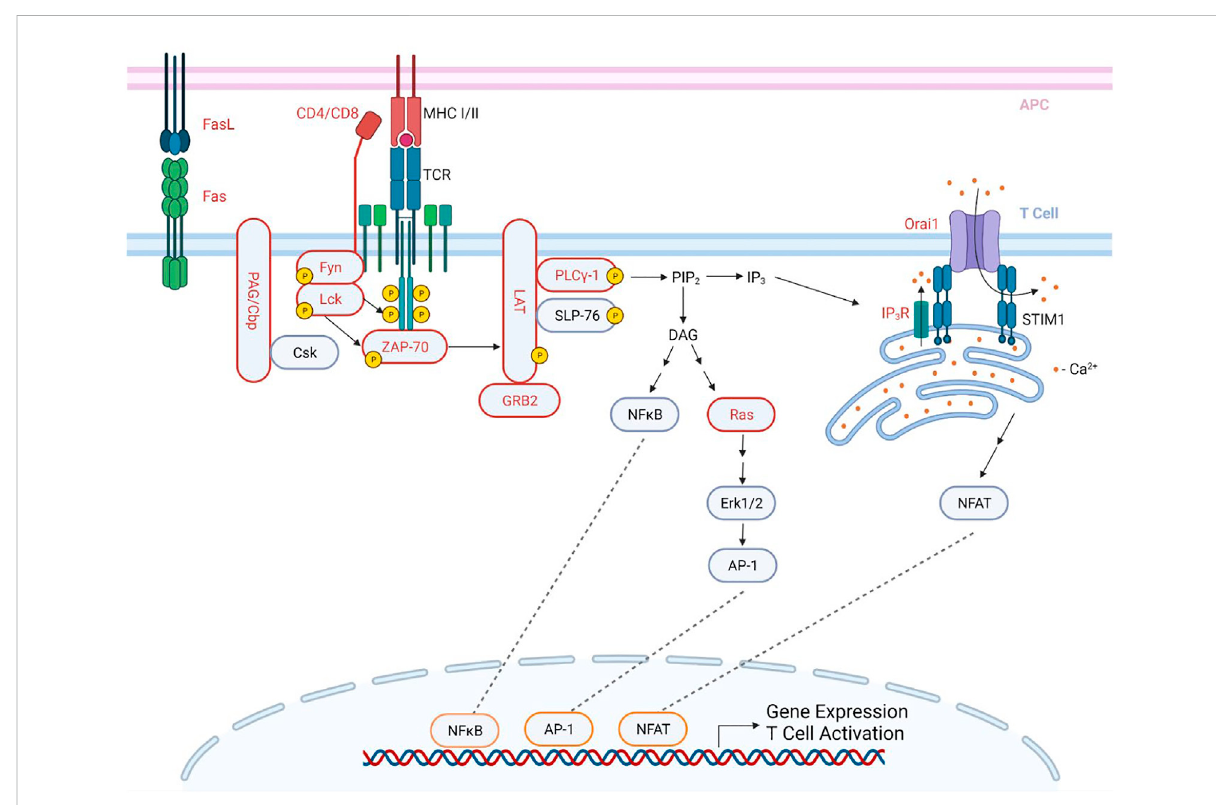
FIGURE 1 S-acylation in the proximal TCR signaling pathway. An antigen peptide, bound to an MHC of an antigen presenting cell (APC), engages and stimulatestheTCRwhileitsco-receptor(CD4/CD8)bindsto theMHC,resultingintheactivation ofseveralsignaling cascades, subsequentlyleading to T cell activation. Upon TCR stimulation, PAG/Cbp is de-phosphorylated, and disassociates from Csk, allowing for the recruitment of Lck to the TCR. Lck is then activated, and phosphorylates the ITAMs of the TCR-associated CD3 and ζ -chains. These phosphorylated ITAMs then act as a docking site for ZAP-70, which is then phosphorylated by Lck. ZAP-70 then phosphorylates and activates the scaffolding protein LAT, which is a dockingsiteforseveralproteins,includingSLP-76,PLC- γ 1,andGRB2.Thesearethenabletobephosphorylatedandactivated,manybyZAP-70.The activation of PLC- γ 1 leads to the formation ofIP 3 and DAG from PIP 2 . IP 3 then binds to the IP 3 R on the ER membrane, leading to the depletion of the ER Ca 2+ stores. This activates STIM1, which then binds to Orai1 at ER-PM junctions, forming an activated CRAC channel, and allowing for Ca 2+ entry into the cell (shown as red dots). This then leads to the activation of the NFAT pathway. DAG activates both the NF κ B pathway and the Ras pathway. These pathways result in the activation of transcription factors, ultimately leading to gene expression and T cell activation. Proteins in red are reported to be S-acylated. APC- antigen presenting cell; TCR- T cell receptor; MHC- major histocompatibility complex; ITAMs-immunoreceptor tyrosine-based activation motifs. Created with